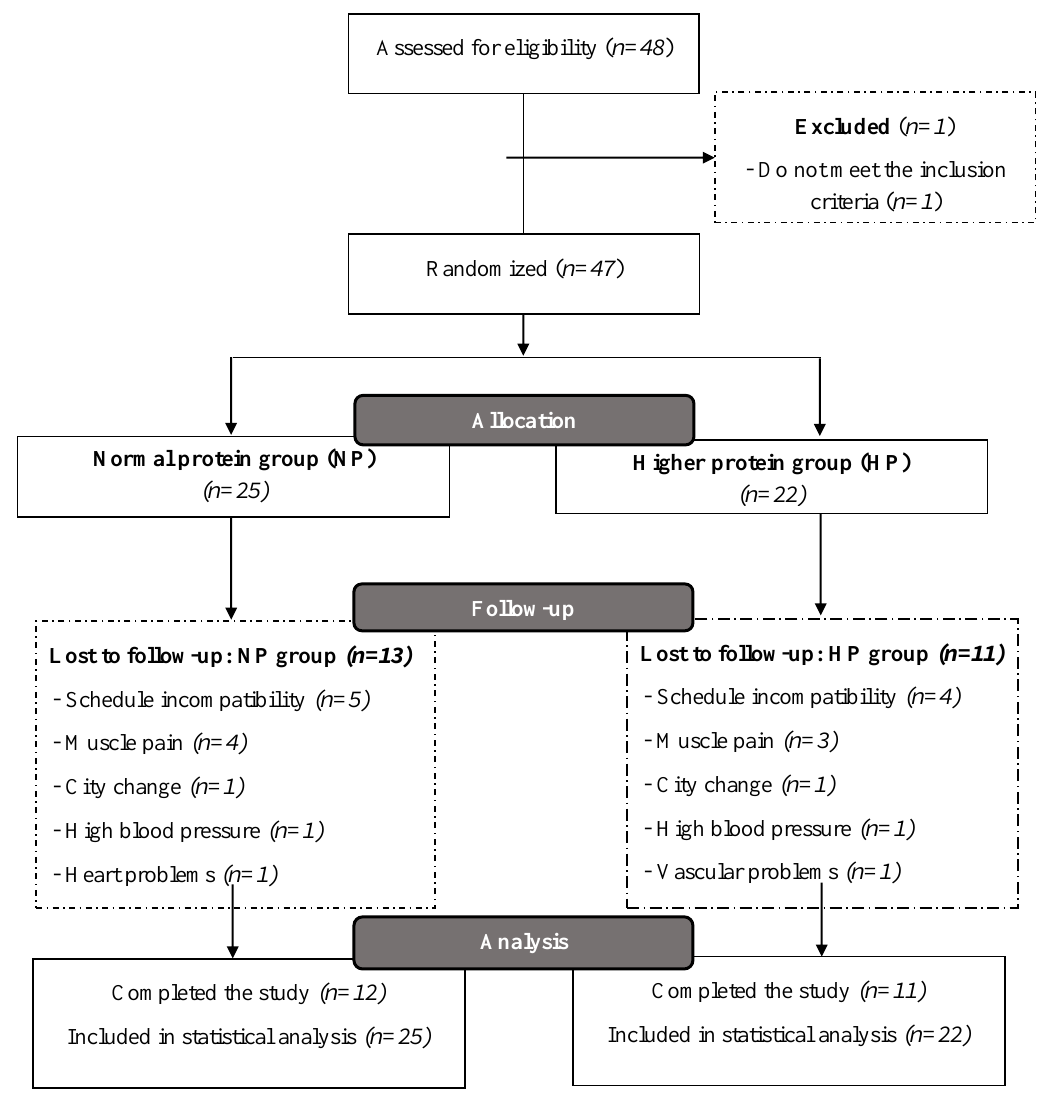
Figure 1. Flowchart of the individuals in the study.